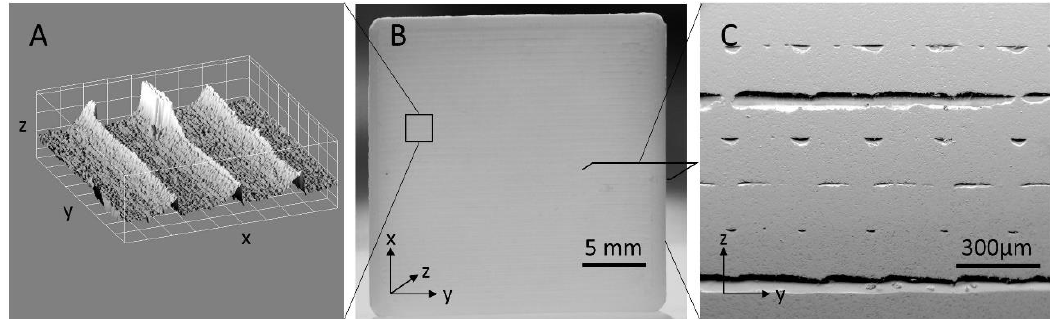
Figure 1. Plate sample: ( A ) Surface topography measured by a confocal microscope (grid pattern 100 µm) reveals a high roughness of a printed plate ( B ). The transmitting light shows homogeneous bulk, but also the surface line structure. ( C ) SEM images of a grinded cross-section of a plate fabricated using fused filament fabrication (FFF) reveals internal cavities due to the printing process and viscosity of the heated filament.